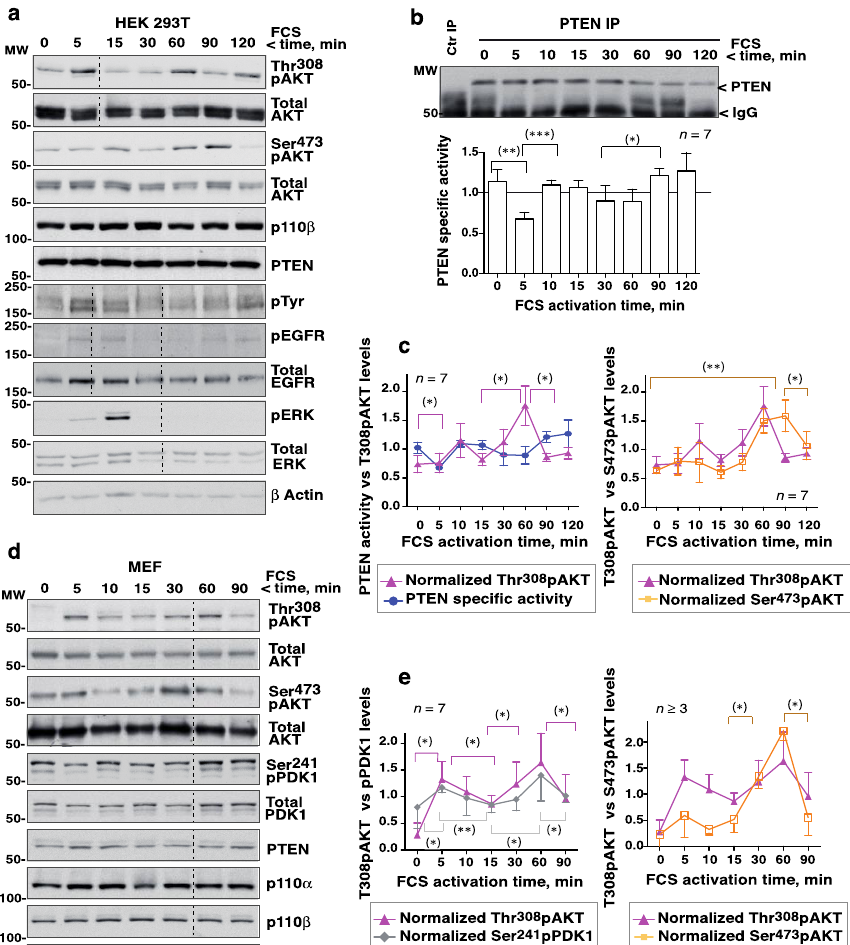
Figure 1. Activation of cells with FCS triggers complementary fluctuations in pAKT levels and PTEN activity. ( a – c ) HEK-293T cells were incubated in serum-free medium (2 h) then activated with FCS (15%) over different lengths of time (indicated). ( a ) Cells were lysed and normalized extracts examined by WB with different Ab (indicated). ( b ) Cell extracts as in ( a ) (1 mg) were incubated with PTEN Ab for immunoprecipitation (IP). Purified PTEN was examined in a phosphatase assay that measures the PTEN phosphatase product PIP 2 . The blot confirmed efficient PTEN IP. The graphs show PTEN activity as the PIP 2 produced by PTEN at each time point (in arbitrary units), normalized for PTEN content. To compare phosphatase activity at different times, the PIP 2 levels at each time were normalized to the mean PIP 2 level (equivalent to 1). For controls (Ctr IP), extracts were incubated with protein A. ( c ) The pAKT signal from assays as in ( a ) was measured, corrected for the AKT and β − actin content, and normalized to the mean pAKT signal for each assay (equivalent to 1). The graphs represent the relative PTEN activity and pAKT levels (Thr308 or Ser473) at each time point (mean ± SD, n = 7). ( d ) MEF were grown to confluence, maintained confluent for 24 h, and then incubated in FCS-deprived medium (2 h) before treatment with FCS (15%) for different times. Extracts were examined as in ( a ). ( e ) The graph shows the Ser473pAKT, Thr308pAKT and Ser241pPDK1 signals normalized to AKT and PDK1 and to β − actin (mean ± SD, n = 7). Dashed lines indicate time points left out from the original gels (originals blots are included as Supplementary Information). * p < 0.05, ** p < 0.01, *** p < 0.001, Student’s paired t